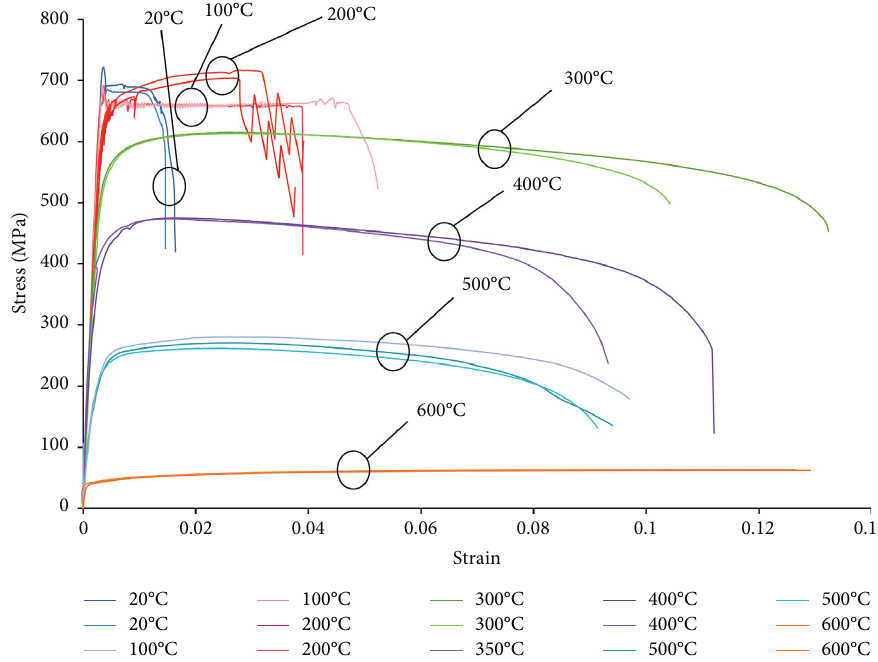
Figure 15: Stress-strain curves of G500 steels at different temperatures. Table 5: Mechanical properties of cold-rolled thin-walled steels at ambient temperature.